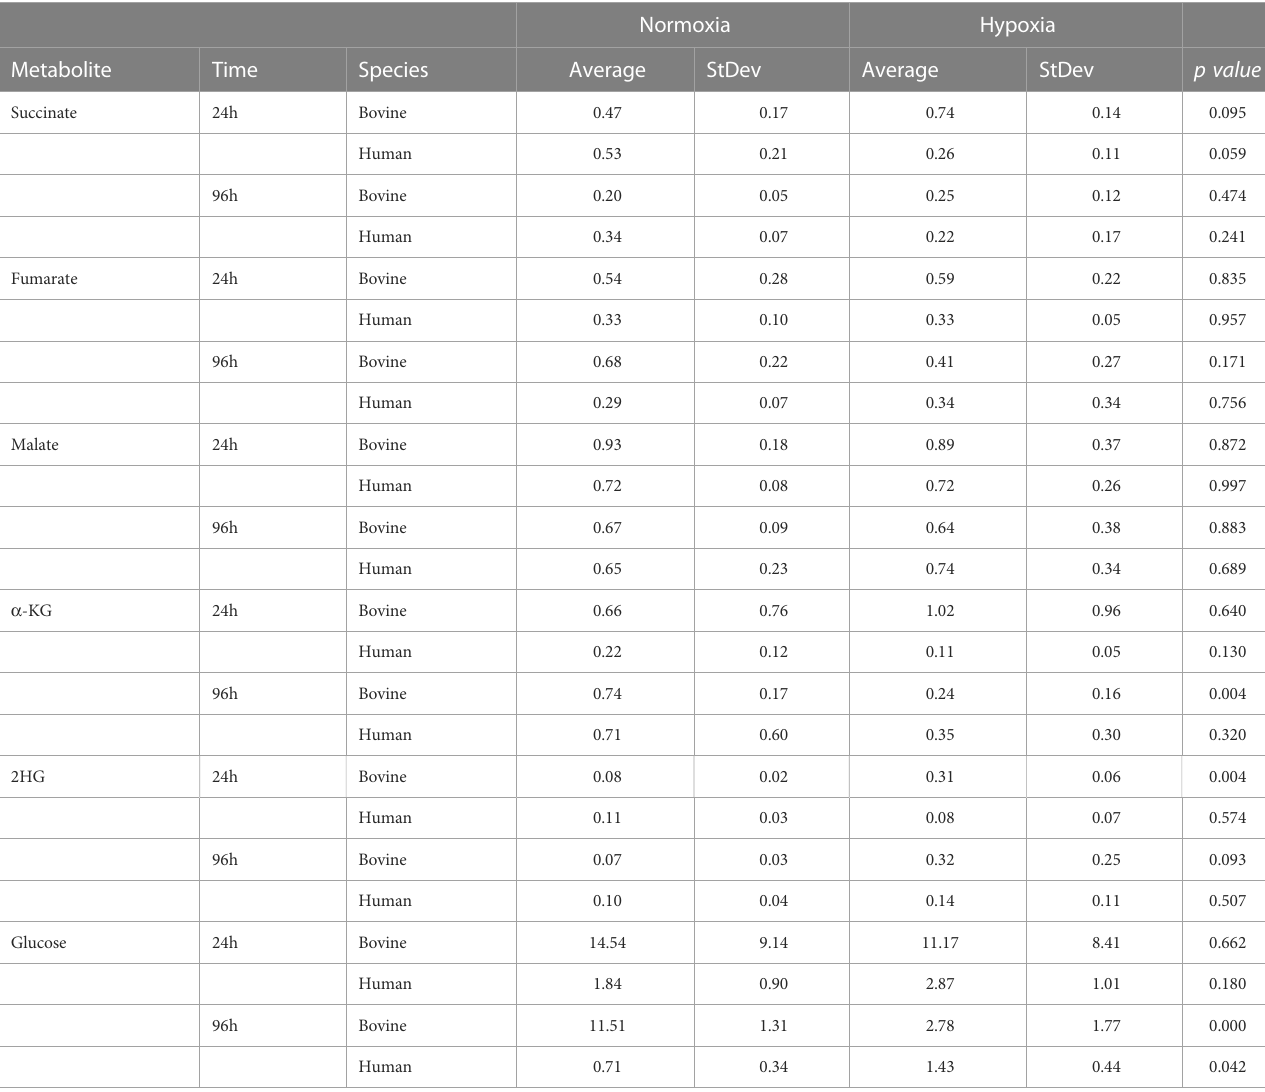
Normoxia Hypoxia